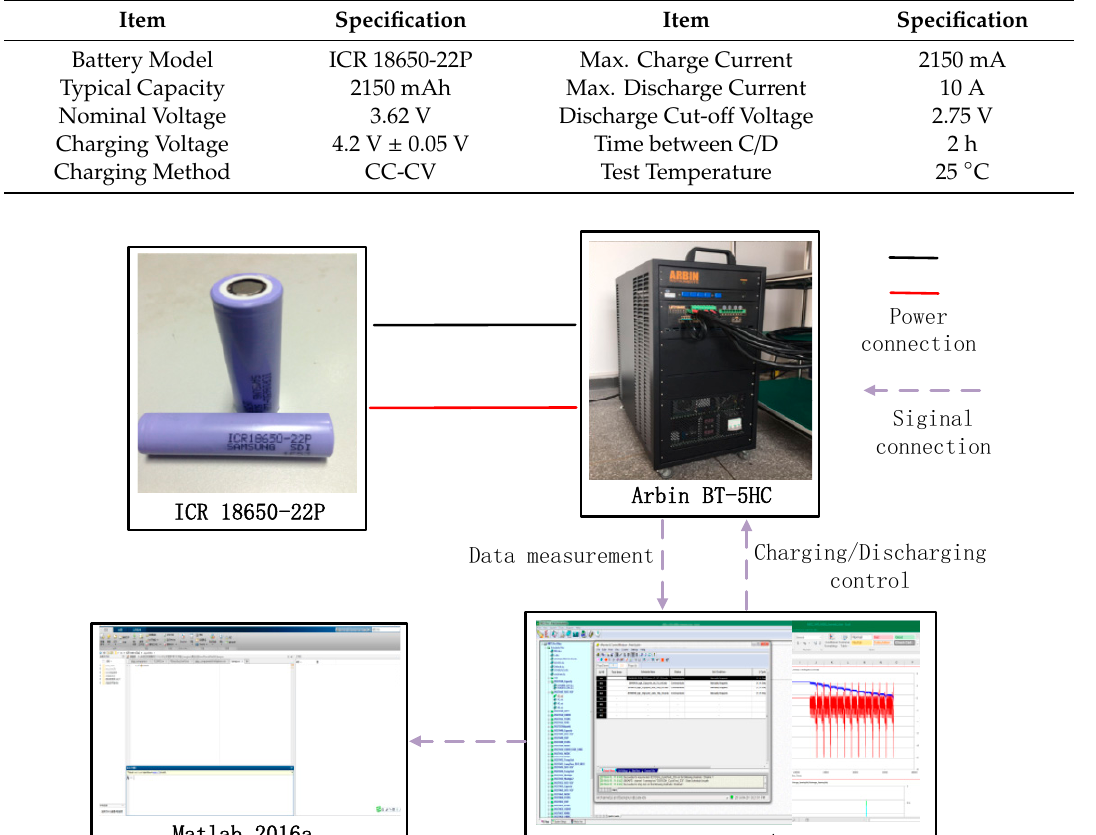
Table 1. Specifications of the tested battery.